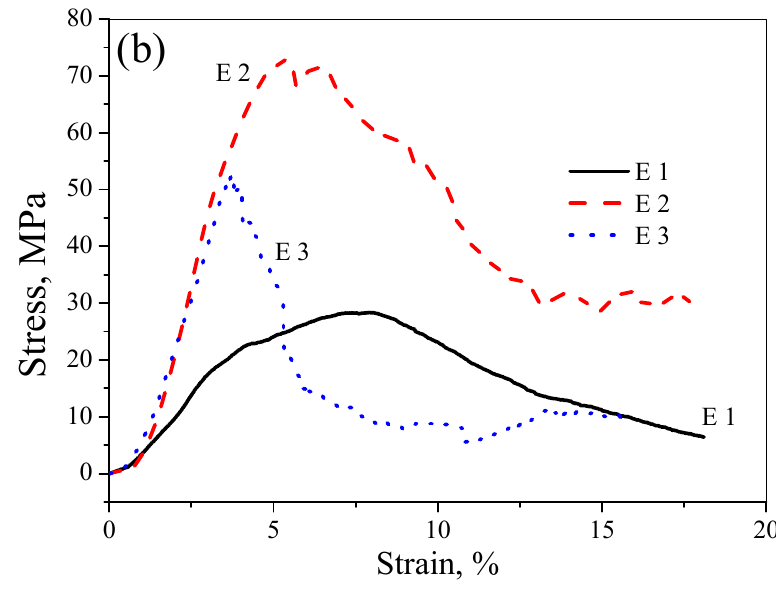
Figure 10. Compressive stress-strain curves of the LAMed Mg-Zn-Zr alloys. ( a ) Horizontal compression, ( b ) Longitudinal compression. Table 5. Mechanical properties of the LAMed porous Mg-Zn-Zr alloys and human bone (HC: horizontal compression, LC: longitudinal compression).